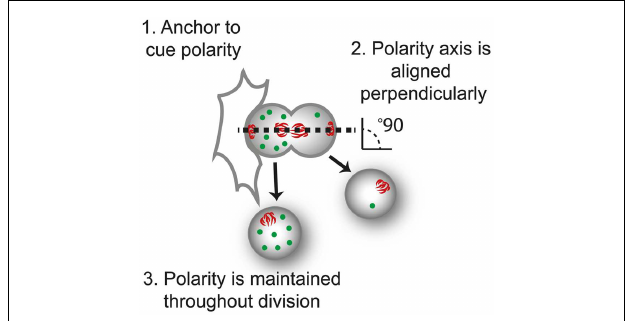
FIGURE 2 |The three requirements of asymmetric cell division . For control of progeny proliferation, death, and differentiation during asymmetric cell division ACD, three requirements must be fulfilled; (1) an anchor to dictate the axis of polarity, in this case another cell; (2) the dividing cell is aligned along the axis of division, usually perpendicular to the anchor (perpendicular orientation shown by the alignment of mitotic spindle, red); and (3) that polarity of the protein (green) is maintained throughout